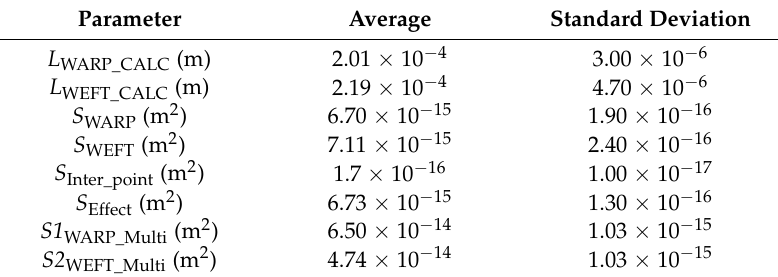
Table 8. The modeling results for RSKCuIv4.